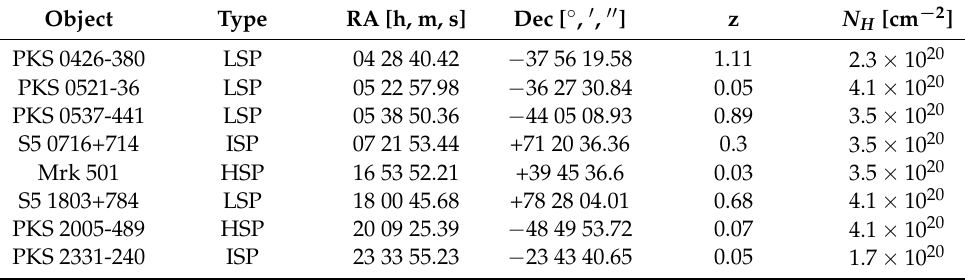
Table 1. Sub-sample of BL Lac type